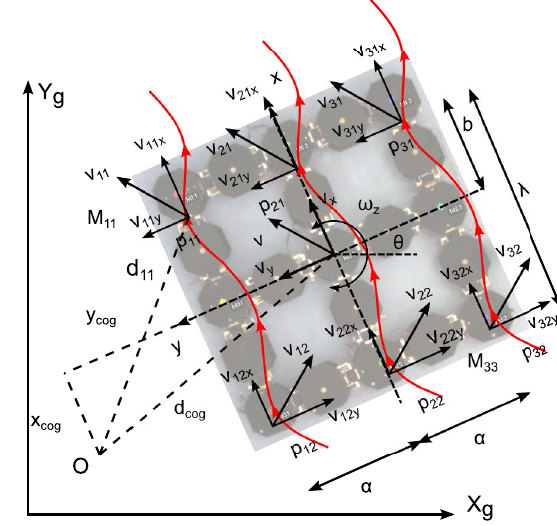
Fig. 9 Control system layout of WORMESH-II Fig. 10 Locomotion kinematics model of